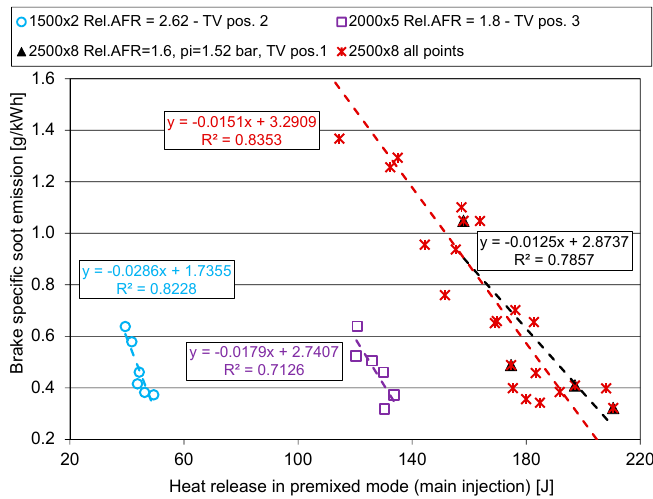
Figure 17. Relationship between heat released in premixed mode and brake specific soot emissions in different operating modes.